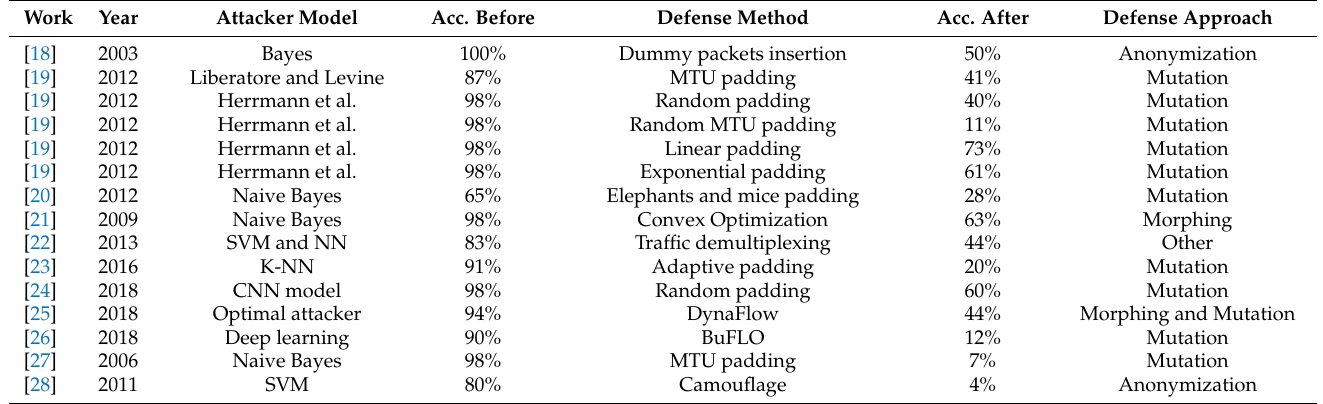
Table 1. Traffic obfuscation